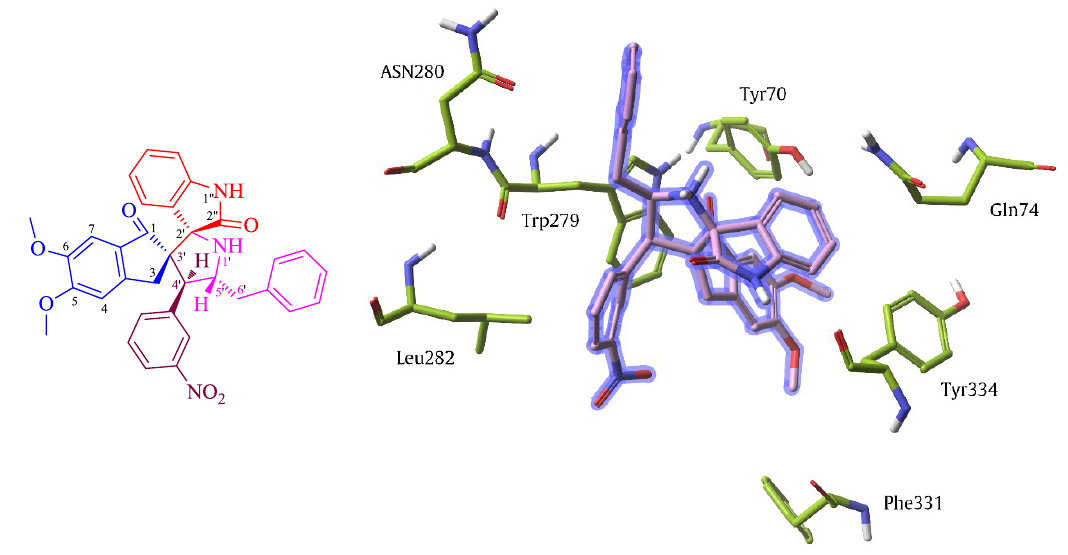
Figure 1. Schematic representation of compound 4f bounded to active site of AChE